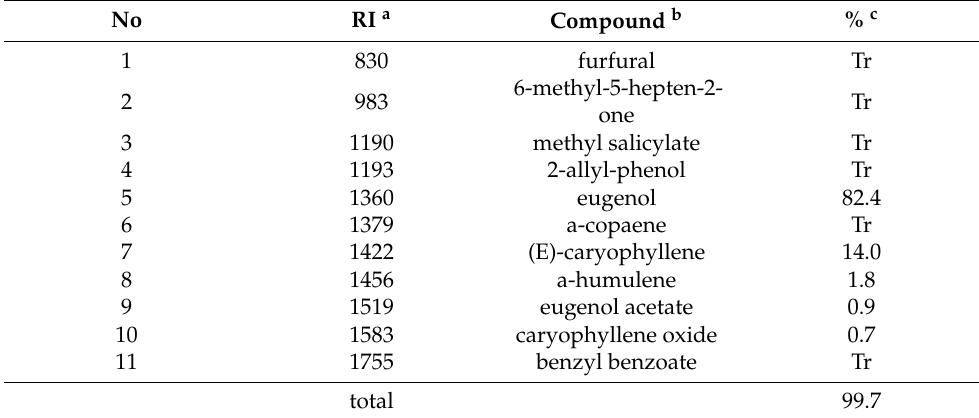
Table 1. Chemical composition of essential oil from S.